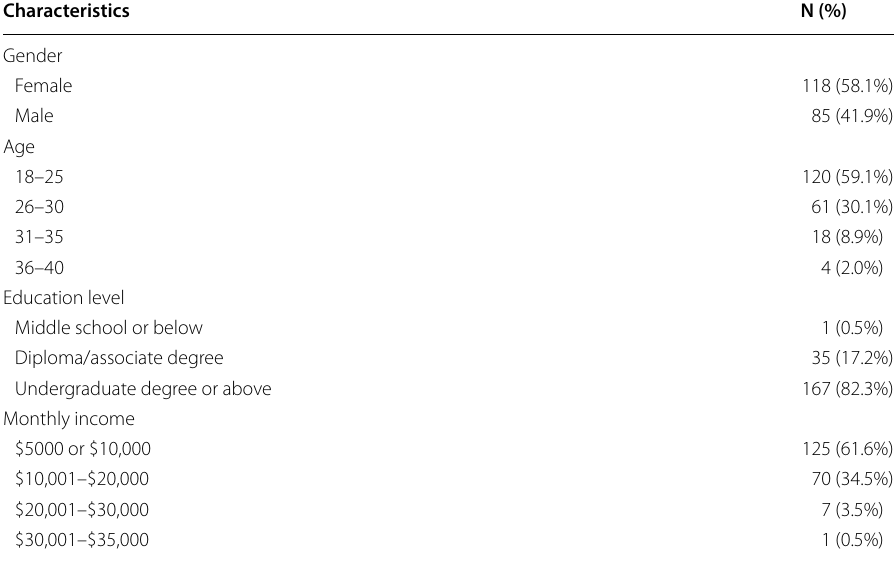
Table 1 Characteristics of